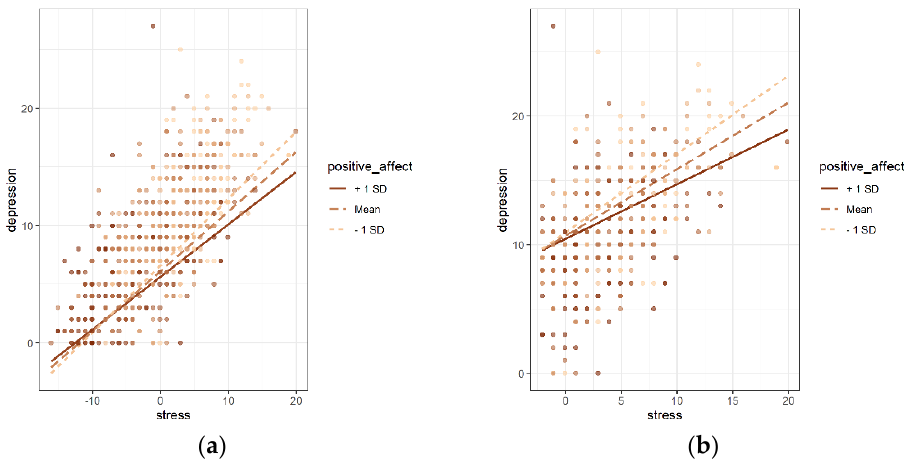
Figure 1. The moderating effect of positive affect in the total group ( a ) and high − stress group ( b ). Similar analyses were conducted for anxiety. As shown in Table 4, positive affect was negatively associated with anxiety ( b = − 0.055, p = 0.019, Model 3), and perceived stress was positively associated with anxiety ( b = 0.501, p < 0.001, Model3). However, the interaction term stress × positive affect showed there was no moderating effect of positive affect between perceived stress and anxiety in the total group ( b = − 0.003, p = 0.307, Model4). In conclusion, this suggested that positive affect had a moderating effect on the relationship between stress and depression rather than anxiety in the total